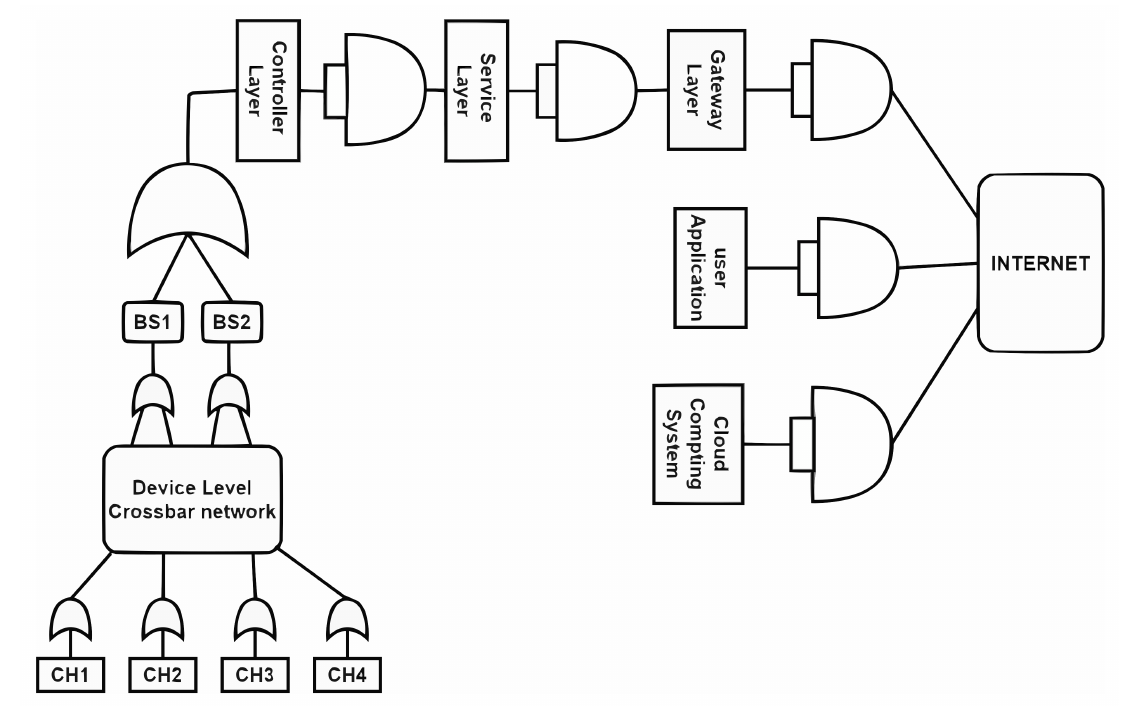
Figure 3. Fault tolerance diagram for the sample IoT network.